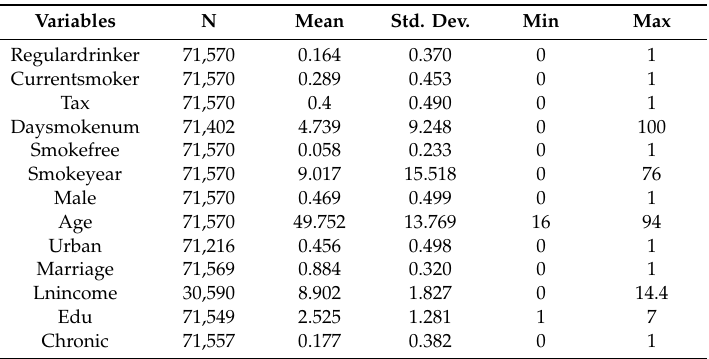
Table 1. Summary